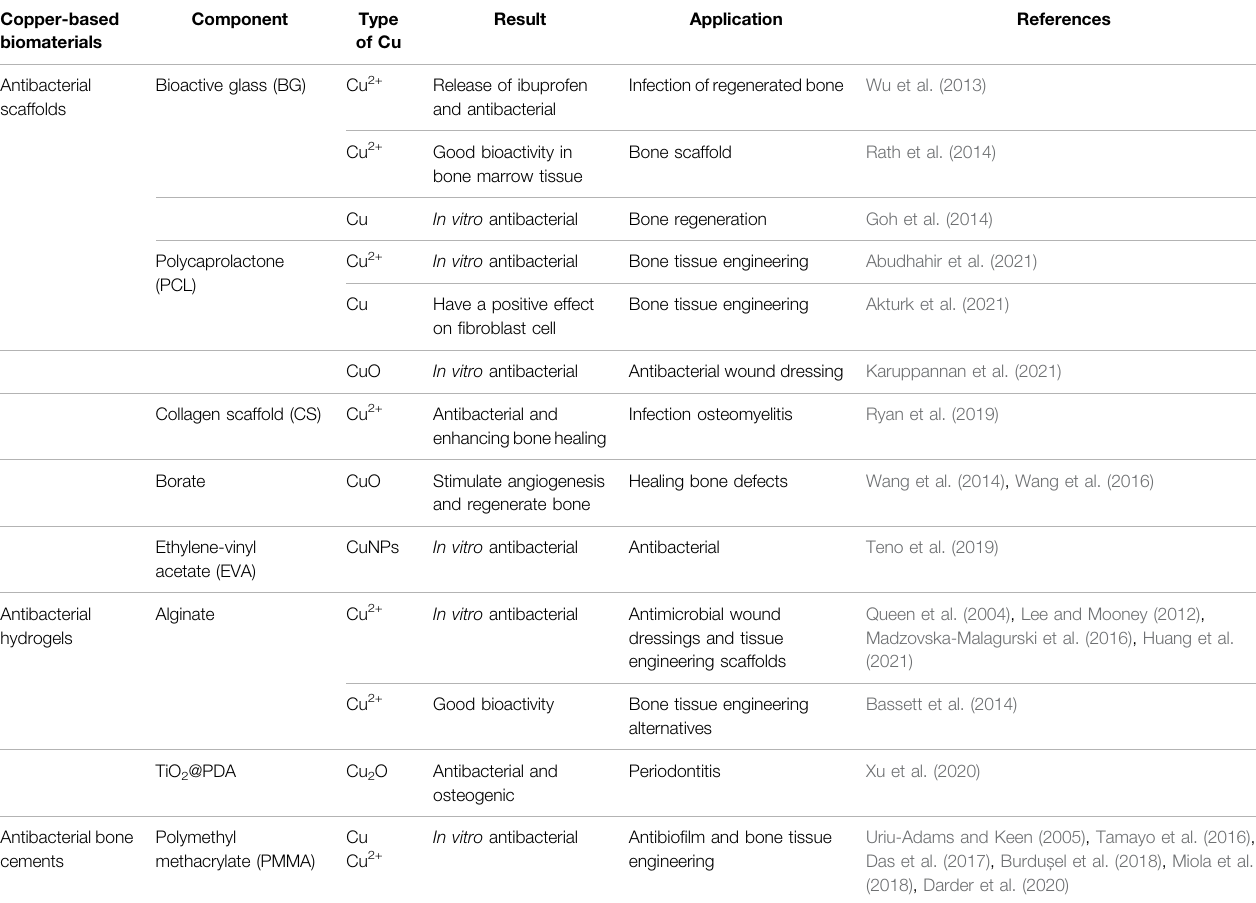
TABLE 1 | Representative examples of copper-based antibacterial